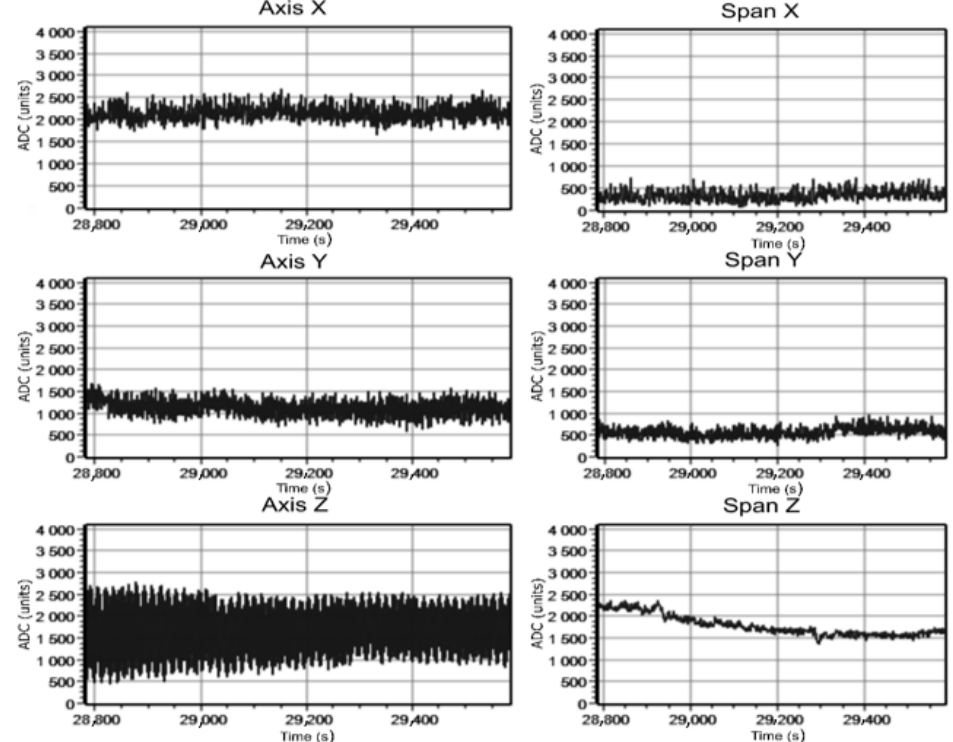
Figure 22. Change in signals at 295A current in a cable during its rotation.